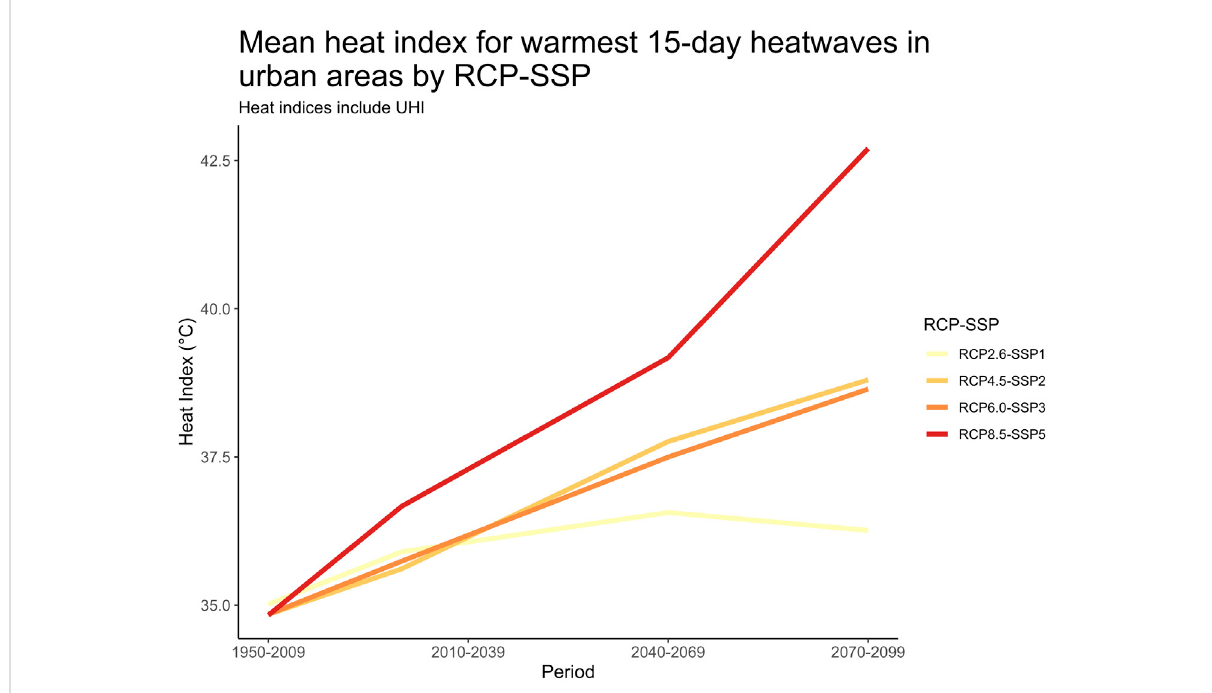
FIGURE 3 Mean heat index for warmest 15-day heatwaves in urban areas by RCP-SSP. This chart presents the average warmest 15-day heatwaves for the different periods by RCP-SSP pair. It demonstrates that for increasing climate change, the average 15-day heatwave heat index climbs. It also demonstrates that for RCP2.6-SSP1 the warmest 15-day heatwaves remain fairly constant in terms of intensity after 2010 – 2039 period, while in the other RCP pathways, the mean heat index for 15-day heatwaves continues to increase throughout the